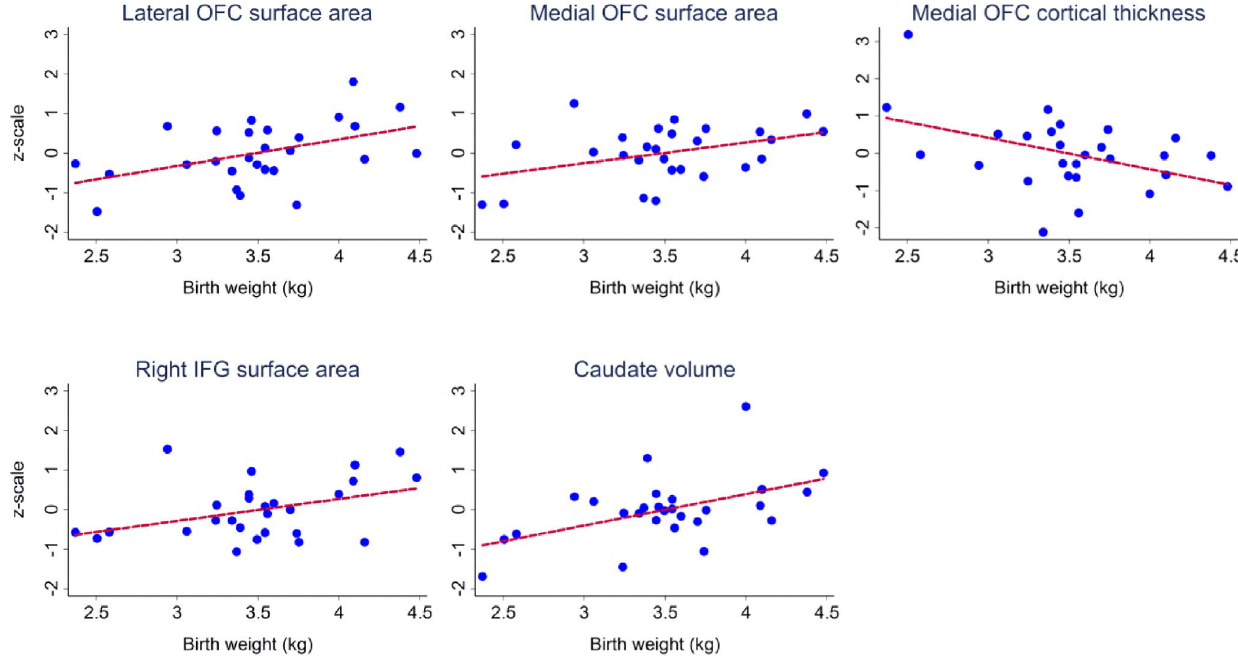
Figure 2. Scatter plots showing statistically significant associations between birth weight and neuroanatomical variables residualized for sex and intracranial volume.